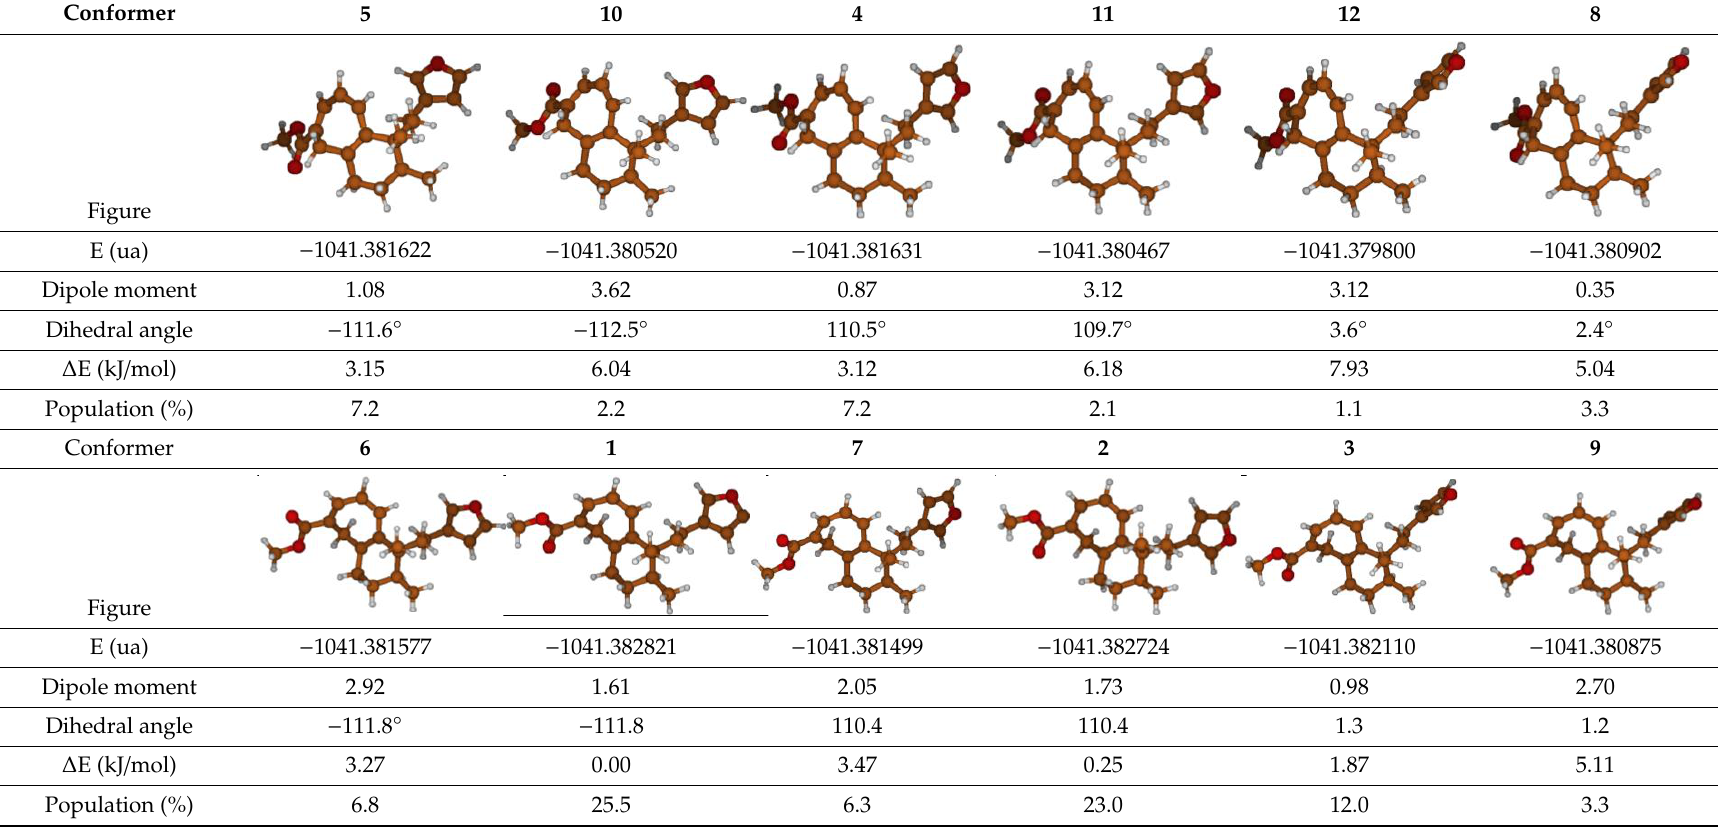
Table 5. Calculated B3LYP/6-311+G(d,p) Energies a , Dipole moments (Debye), relatives Energies a , (C 13 -C 14 -C 15 -C 18 ) dihedral angle, equilibrium population at 25°C and figures of conformations 1-12 of the 8 S , 9 R isomer of methyl dodovisate A ( 2 ).